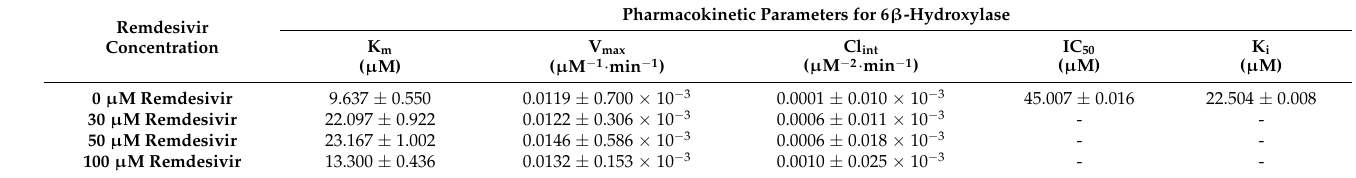
Table 3. V max , K m and Cl int values and inhibition patterns of CYP3A2 isoenzyme in the presence of dexamethasone substrates and remdesivir (inhibitor). The mean of three experiments is taken ± SD ( n = 3). Note: p < 0.002.